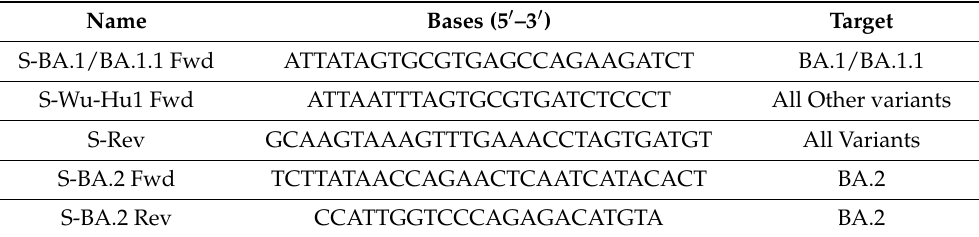
Figure 1. Primer Positions and Method overview. Genomic coordinates of the primer binding locations in the Wu-Hu1, BA.1/BA.1.1, and BA.2 viral variant genomes for ( A ) the BA.1/BA.1.1 targets and ( B ) the BA.2 targets. ( C ) Schematic and estimated timeline of RT-qPCR assay. Table 2. Primer sequences used in this study.